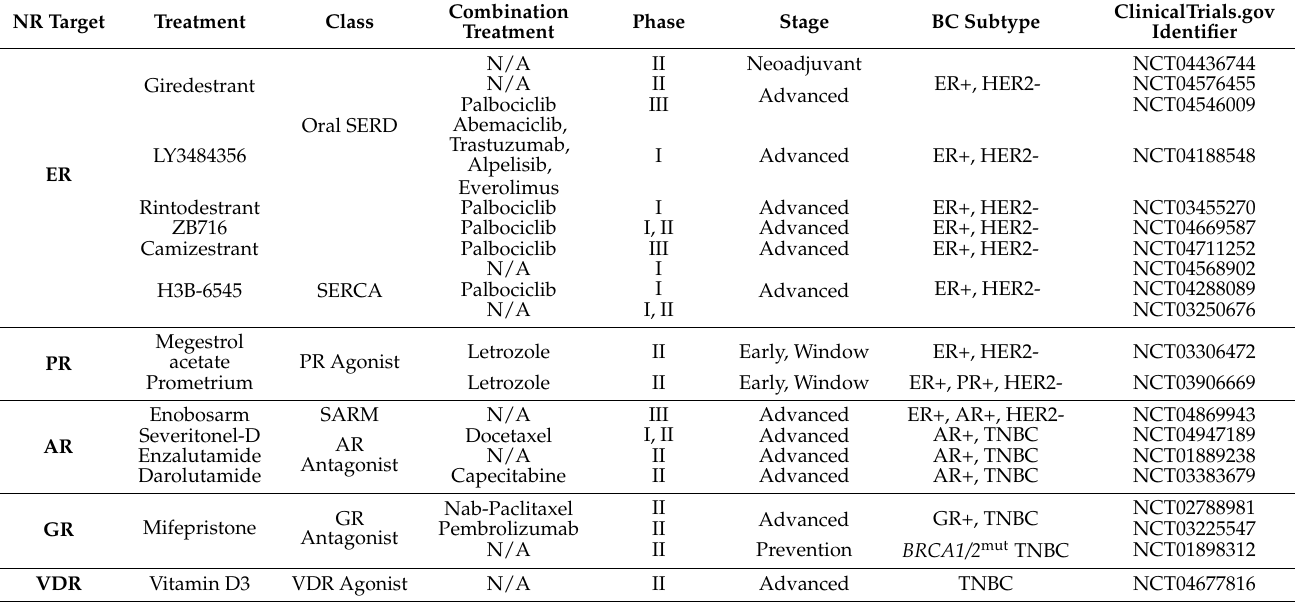
Table 2. Clinical trials in progress that are investigating nuclear receptor-directed therapies in breast